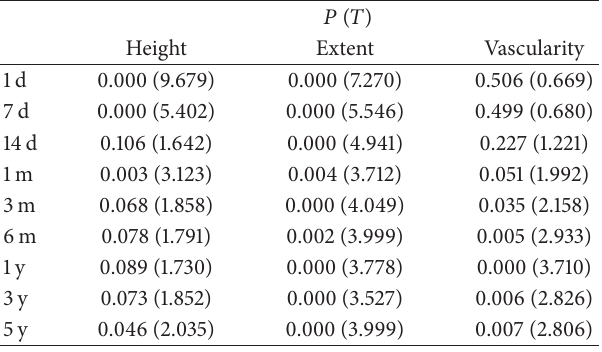
Table 5: The 𝑃 value and 𝑇 value between the Ologen group and MMC